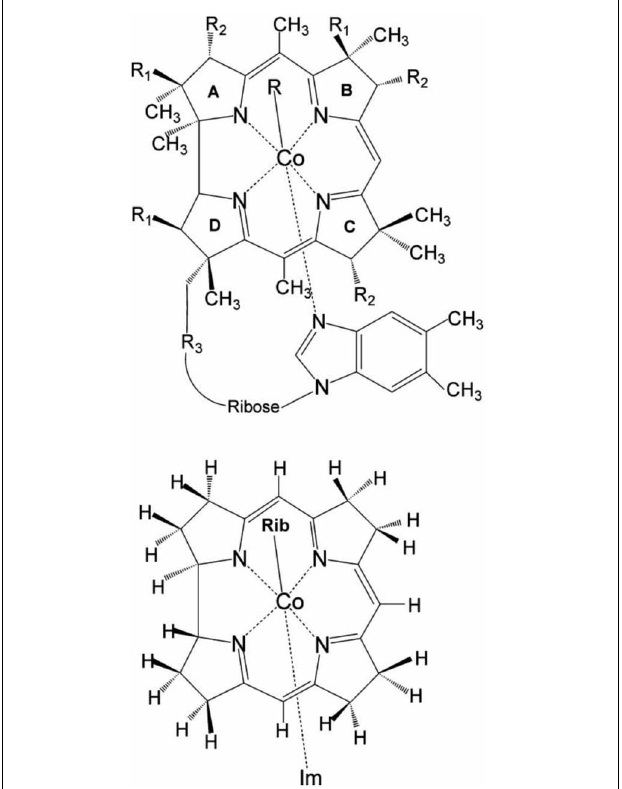
FIGURE 1 | Upper: Molecular structure of vitamin B 12 derivatives where R = Me, Ado, Et, Prop, CN, OH or N 3 where R 1 = CH 2 CONH 2 , R 2 = CH 2 CH 2 CONH 2 , and R 3 = (CH 2 ) 2 CONHCH 2 CH(CH 3 )OPO − 3 . Lower: Structural model of RibCbl employed in present work (Rib refers to ribosyl with 5-hydroxyl group substituted by H atom). Reprinted (adapted) with permission from Jaworska et al. (2007). Copyright (2014) American Chemical